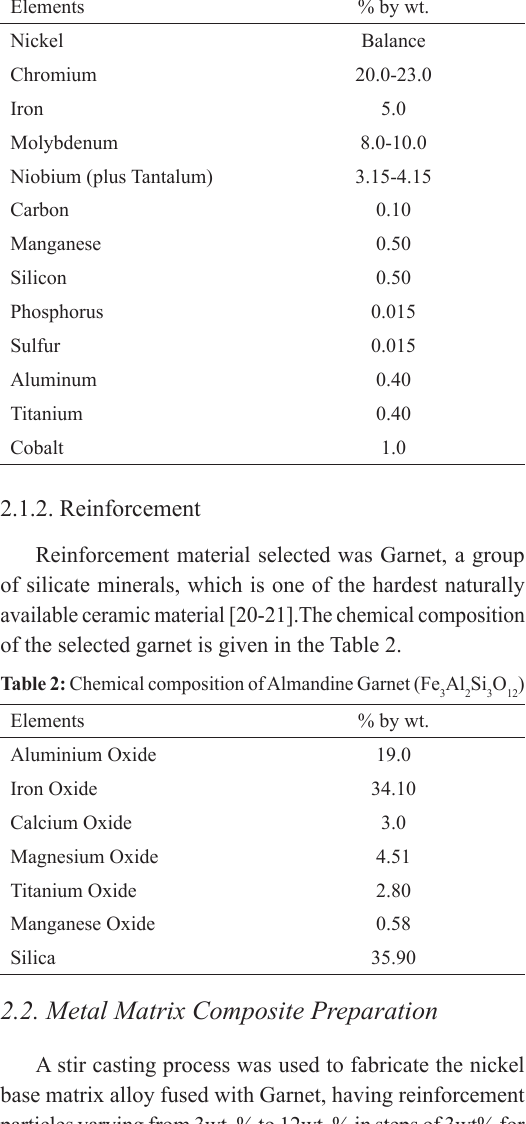
Table 1: Chemical composition of matrix material ASTM A 494 M grade nickel base alloy. (Inconel-625) Elements % by wt.